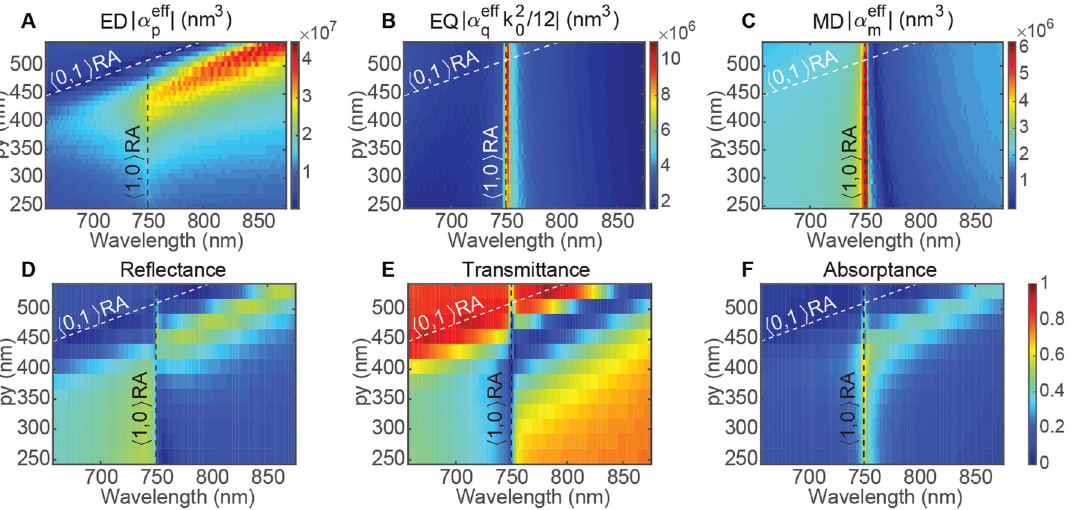
Figure 7: (Color online) Effective polarizabilities of (A) ED, (B) EQ, and (C) MD nanoparticle multipoles in the periodic nanoparticle array with fixed lattice periods p x = 510 nm and variant p y . The calculations are based on the analytical dipole-quadrupole approximation model. (D) Re fl ection,(E)transmissionand(F)absorptionlinearspectrainperiodicarraywith fi xedlatticeperiods p x =510nmandvariant p y .Thecolorbar is the same for (D) – (F) panels. The dashed lines show the 〈 1 , 0 〉 and 〈 0 , 1 〉 Rayleigh anomaly wavelengths.